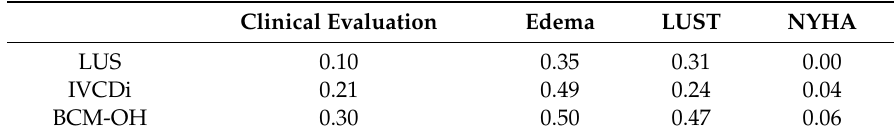
Table 9. Kappa test of Cohen for HD + PD